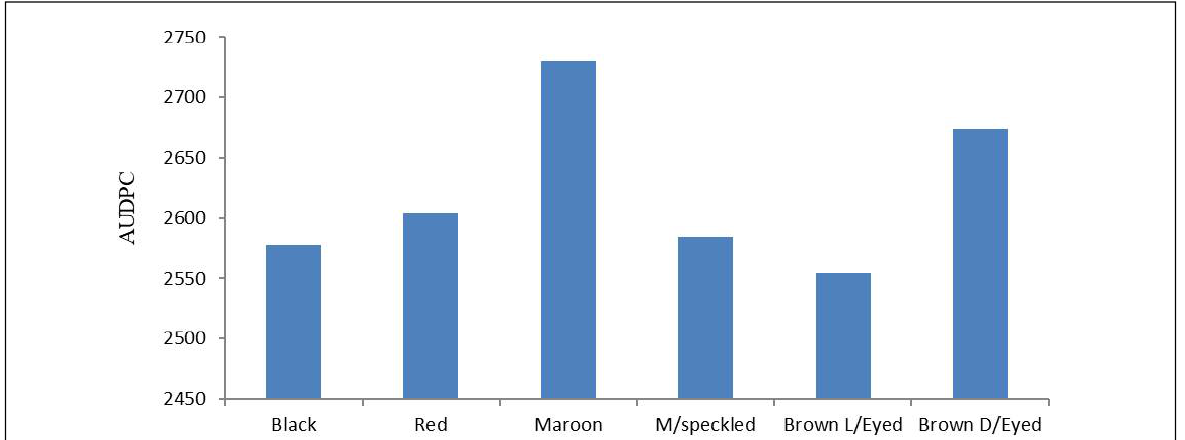
Figure 2: Area under disease progress curves of Fusarium wilt of Bambara nuts for the six